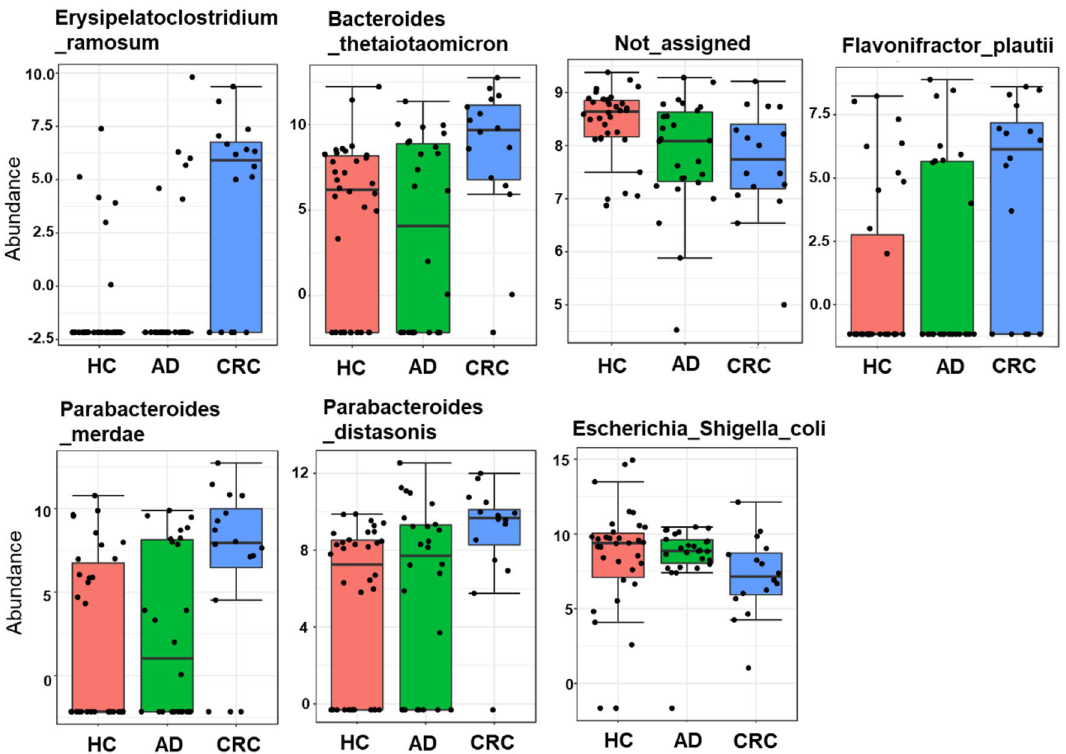
Figure 3. The significant difference in bacterial abundance of the individual bacterium at the species level in the mucosal tissue samples among healthy control (HC), adenoma (AD), and colorectal cancer (CRC) subjects. Data are shown as log–transformed count and p <